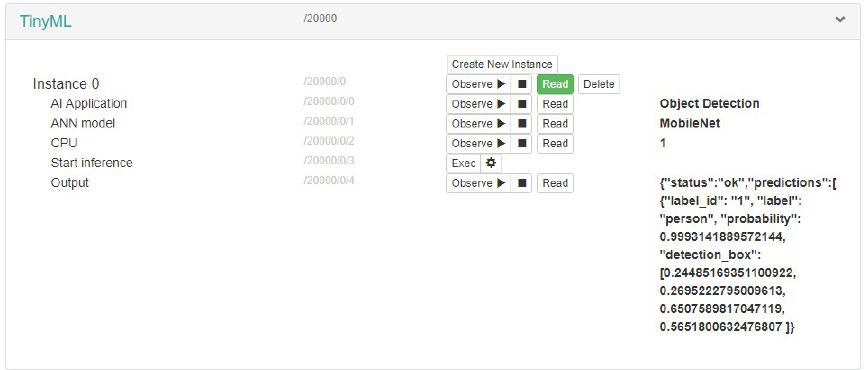
Figure 4. The VIO web